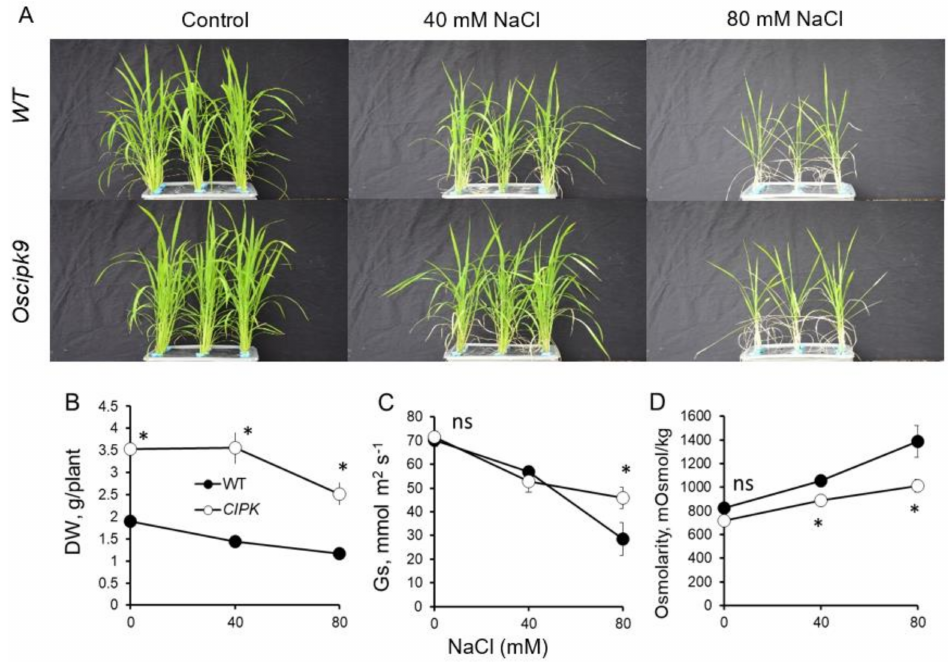
Figure 1. Effects of salinity stress on growth and phenotype of Oscipk9 and WT plants. ( A ) plant phenotype under control, mild (40 mM NaCl for 3 weeks) and severe (80 mM NaCl) treatments; ( B ) plant dry weight; ( C ) stomatal conductance; and ( D ) shoot osmolality. Closed circles—WT; open circles—Oscipk9 mutant line. Data are the mean ± SE ( n = 18). Asterisk denotes significant difference between WT and cipk9 plants at p <